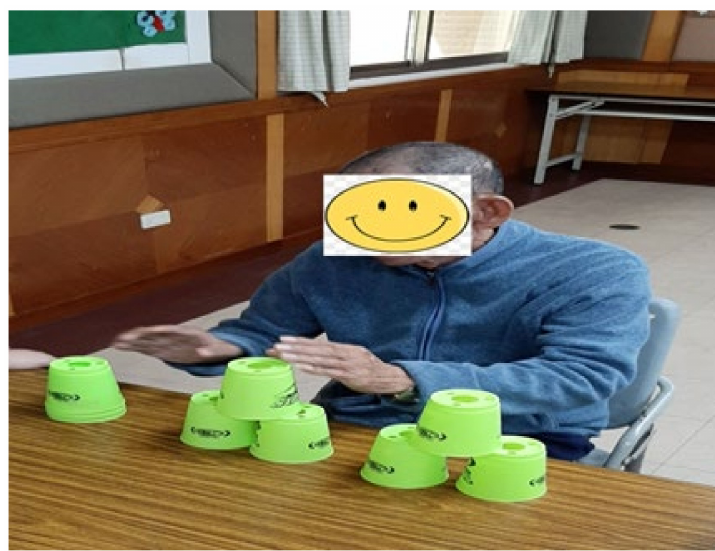
Figure 7. A participant stacking